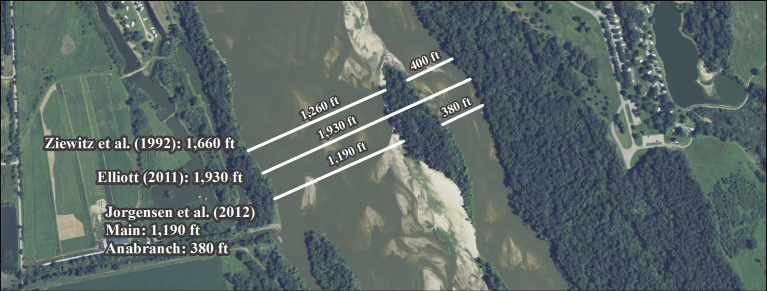
Examples of different width definitions of in-channel width measurements. The channel width in the example ranged from 116 m (Jorgensen et al., 2012 definition) to 588 m (Elliott, 2011 definition). 2009 Farm Service Agency (FSA) National Aerial Imagery Program (NAIP) aerial imagery was used to create the figure.